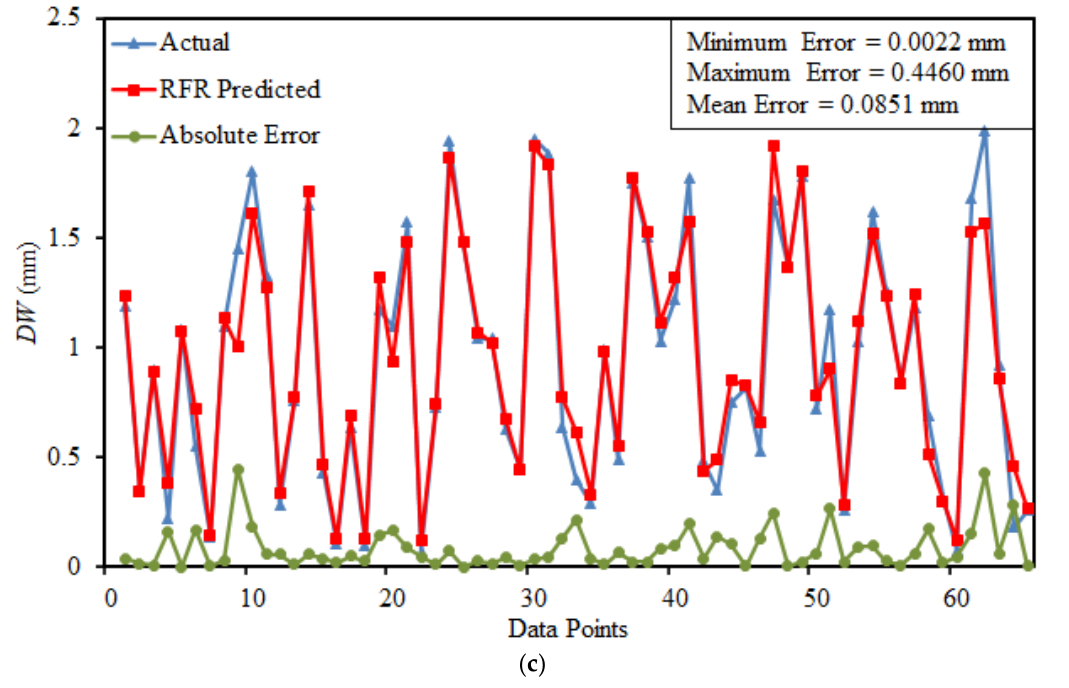
Figure 5. Performance of RFR model ( a ) Optimized R 2 for 20 sub models ( b ) Regression analysis ( c ) Absolute error plot.